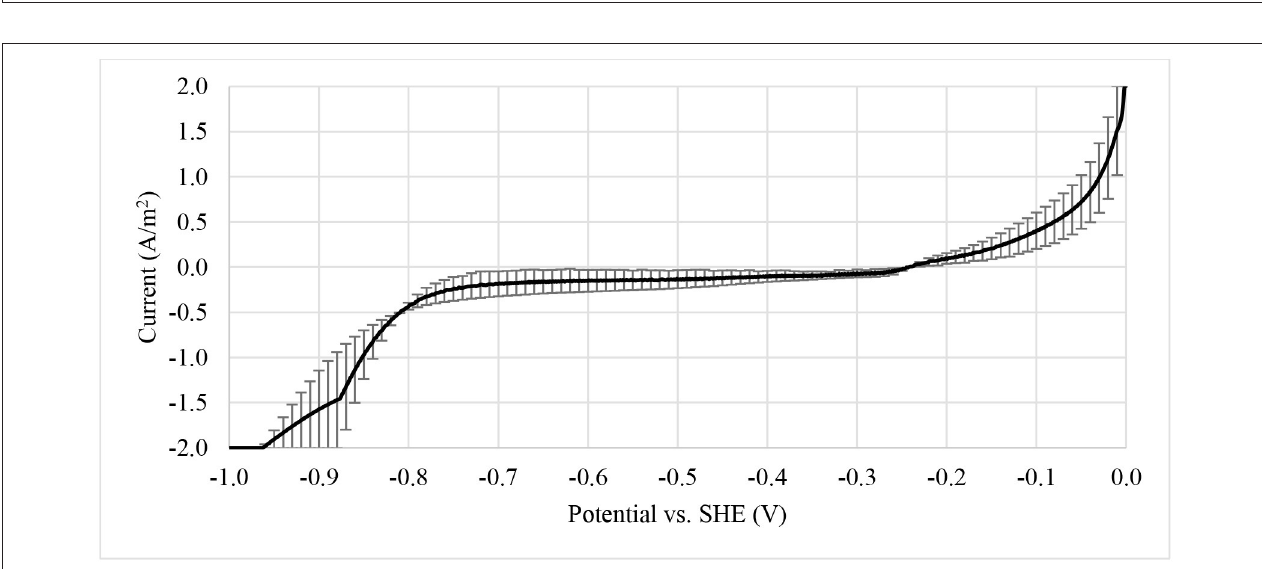
FIGURE 4 | Polarity reversal scan from 0 to − 1.0V vs. SHE at scan rate of 0.2 mV/s. The information was obtained to determine the minimum potential to be fixed on bioelectrode for hydrogen